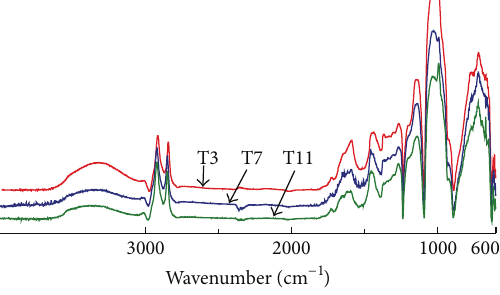
Figure 3: ATR-IR spectra of lacquer